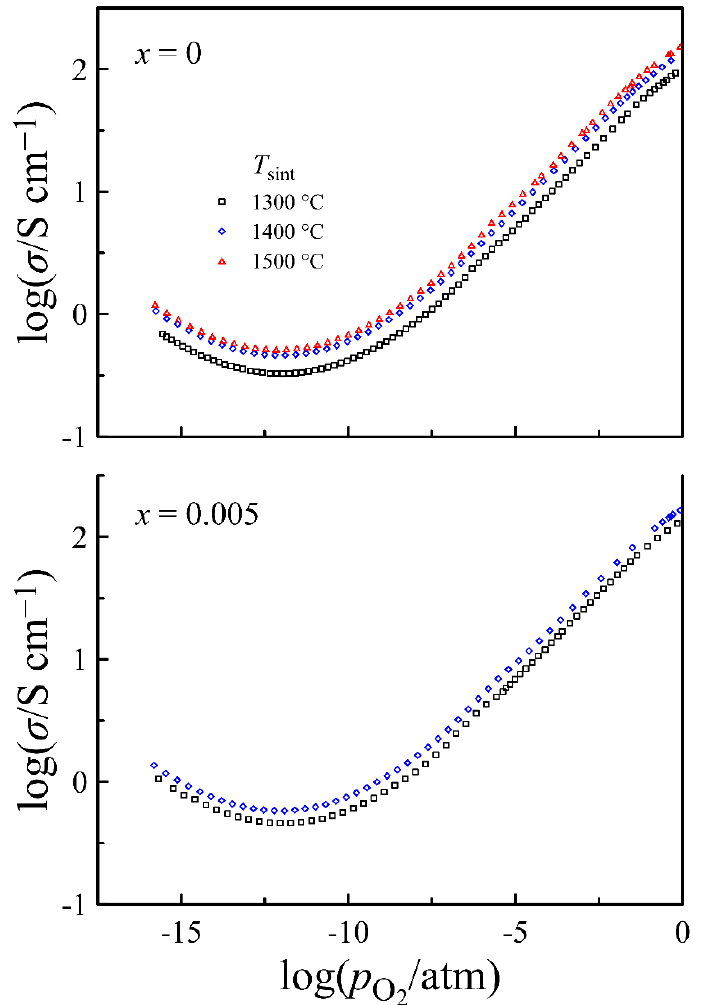
Figure 6. Electrical conductivity of La 0.5 − x Sr 0.5 FeO 3 − δ ceramics sintered at different temperatures, measured at 950 °C versus oxygen partial pressure.